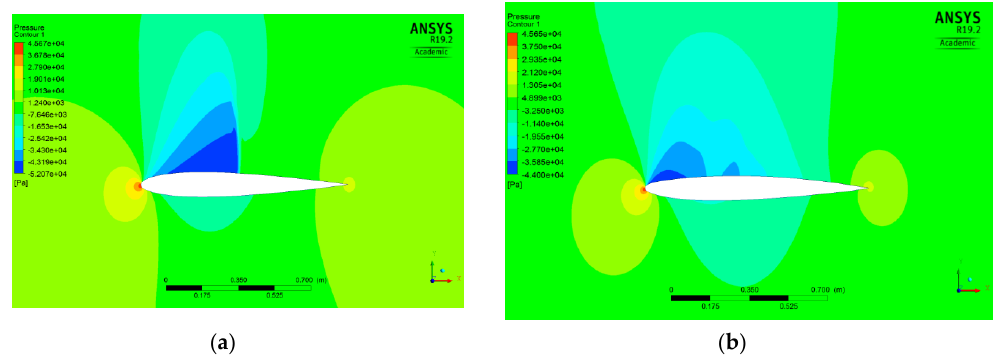
Figure 8. Static pressure distribution for the initial shape (NACA 0012) ( a ) and the optimal shape (at iteration 15) ( b ).